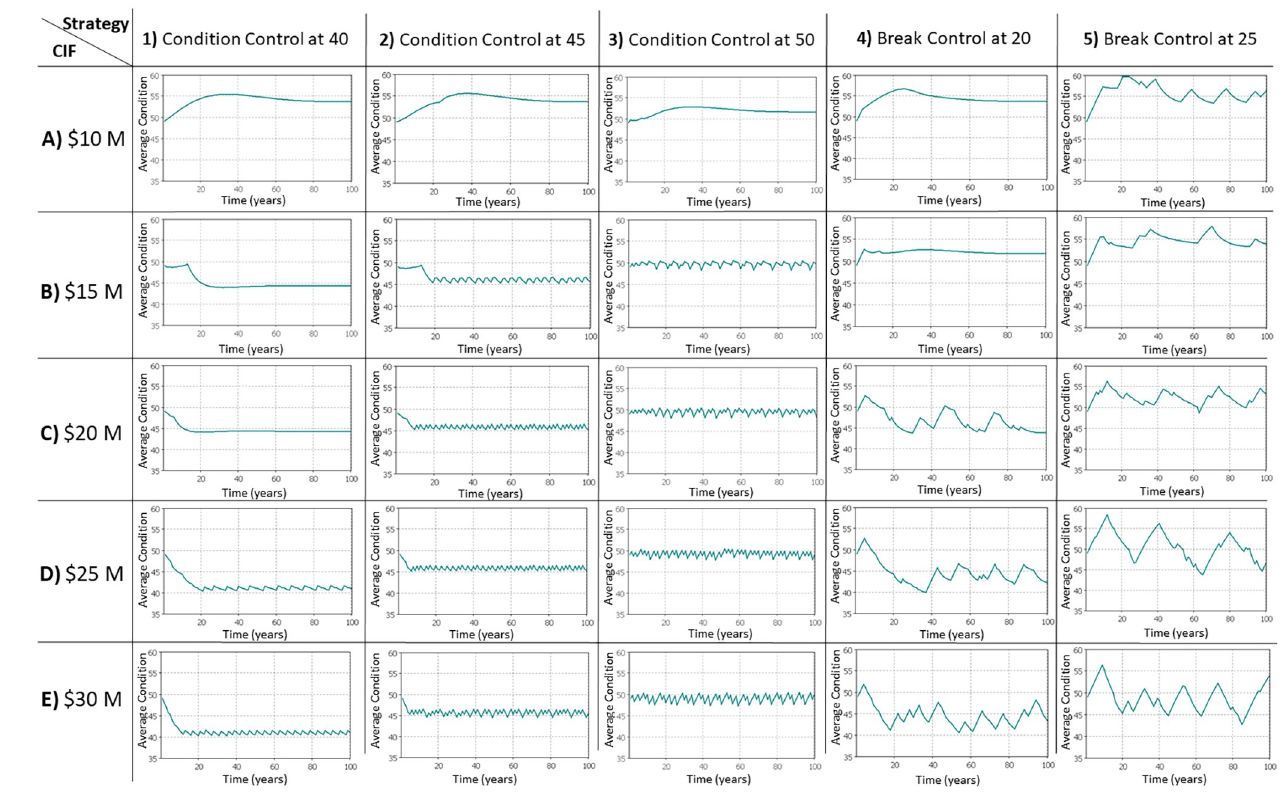
Fig 8. Modeling regimes of network average condition under various